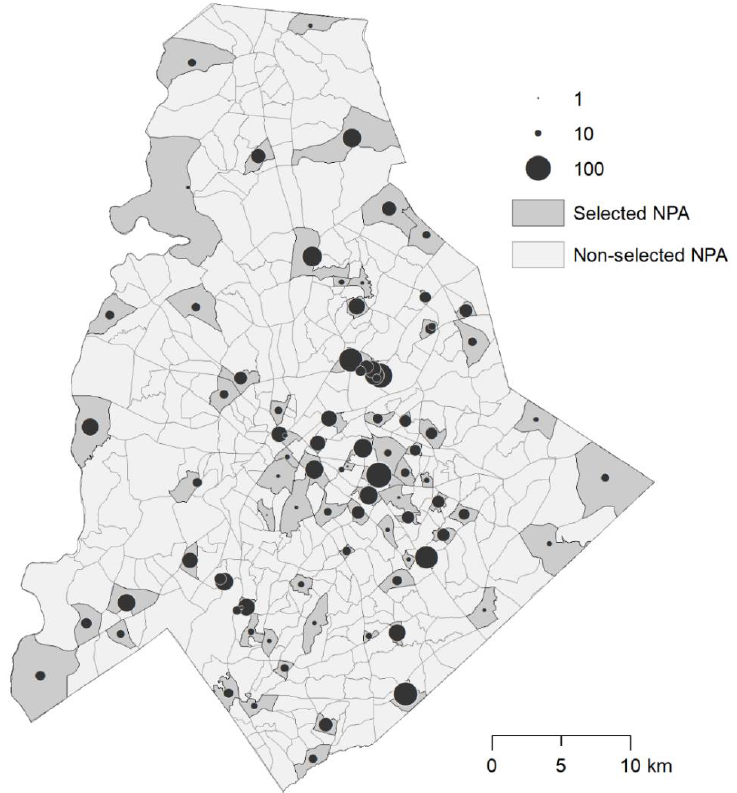
Figure 7. Average number of gravid Ae. albopictus caught each week from May 26, 2017 to August 21, 2017.